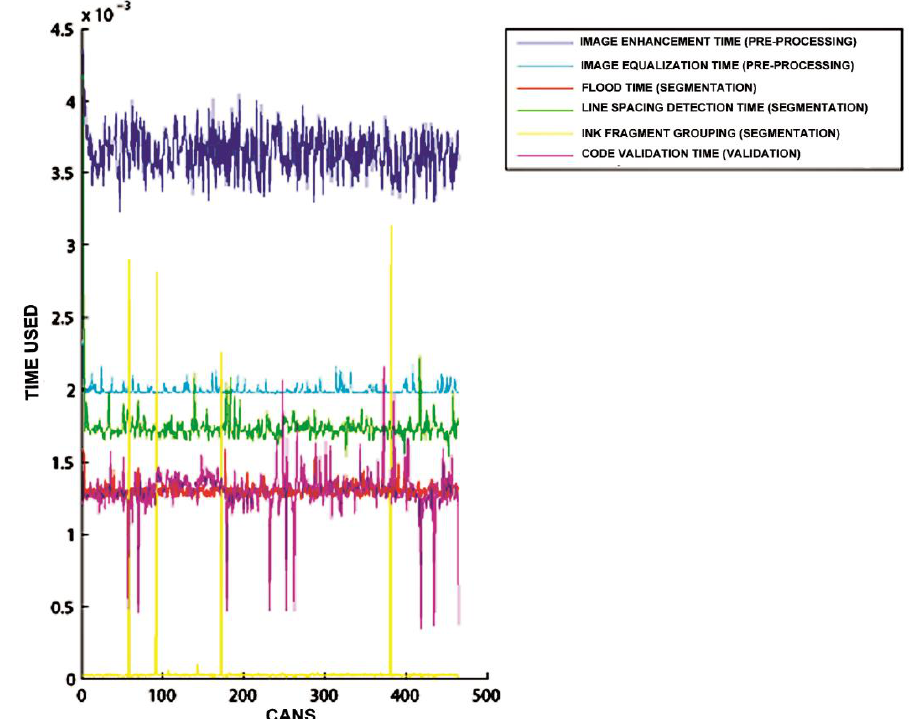
Figure 16. In this graph, the ordinate axis is the time taken, while the abscissa axis represents each of the cans. It can be seen that the validation algorithm has significant oscillations. These oscillations are caused by the variable number of repeated matching attempts with merged fragments and by the variable number of morphologies that are checked until the maximum similarity is obtained.